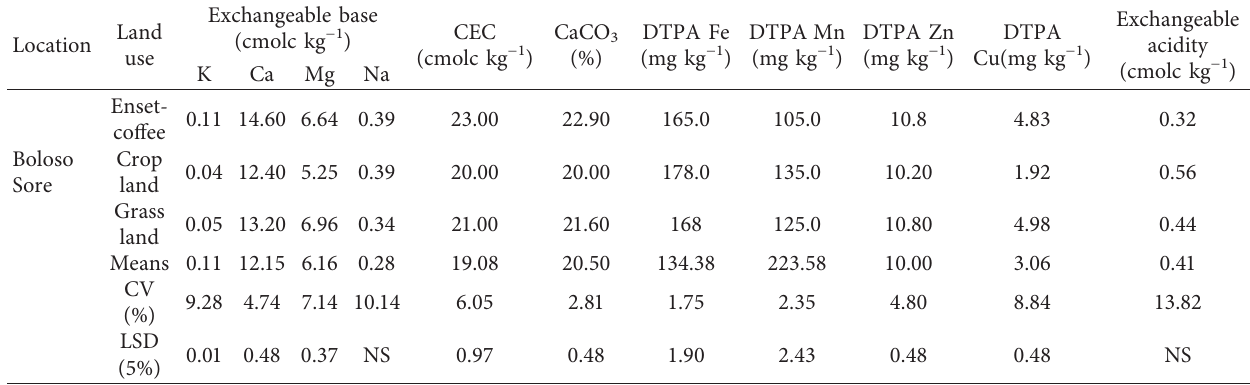
Table 3: Distributions of potassium forms of the soils as influenced by locations and land uses systems.